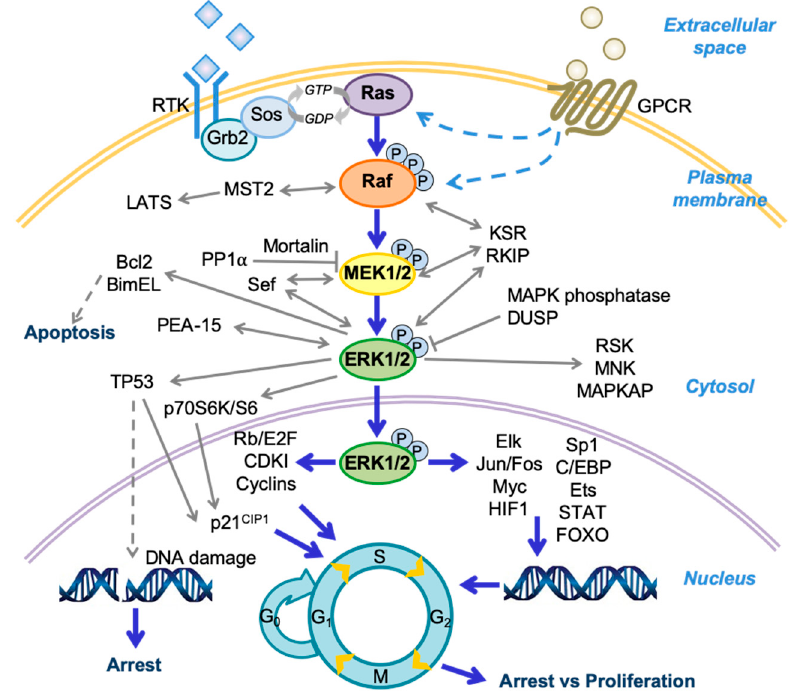
Figure 1. A schema of the Raf/MEK/extracellular signal-regulated kinase (ERK) pathway and its regulators and effectors. Growth factor receptor-bound protein 2 (Grb2); son of sevenless (Sos); large tumor suppressors (LATS); dual-specificity phosphatase (DUSP); ribosomal S6 kinase (RSK); mitogen activated protein kinase (MAPK)-activated protein kinase (MAPKAP); cyclin-dependent kinase inhibitor (CDKI); Hypoxia-inducible factor 1 (HIF1); CCAAT-enhancer-binding protein (C/EBP); signal transducer and activator of transcription protein (STAT); forkhead box protein O (FOXO); protein phosphorylation (P).